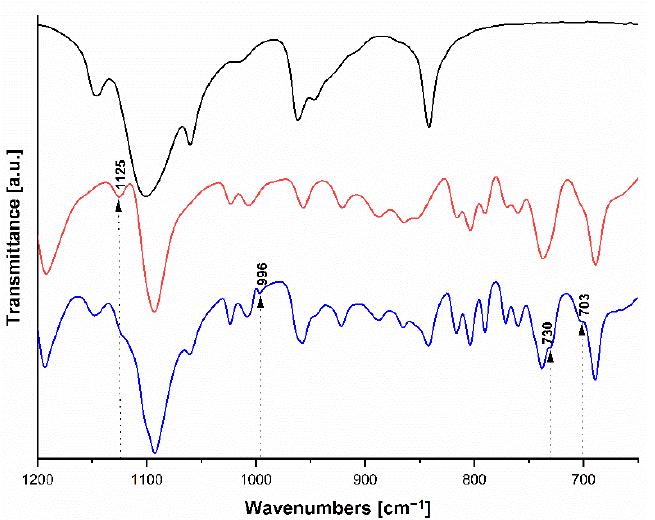
Figure 8. Spectral comparison among Fen (red), neat P 407 (black), and physical mixture between Fen and P 407 (blue) to pinpoint the disappearance and appearance of new peaks in the mixture spectrum.